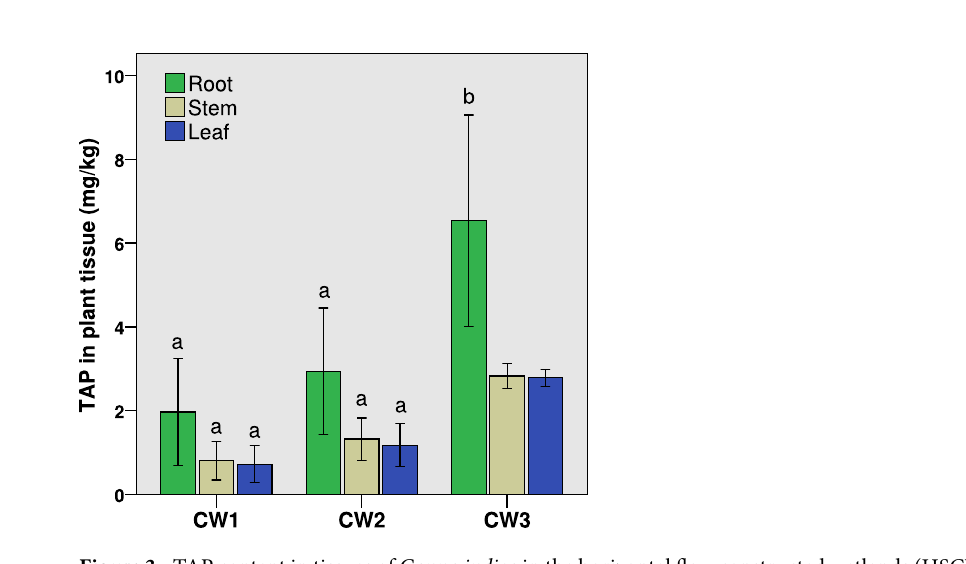
the TAP accumulation in plants and substrates to the total TAP removal were calculated based on the TAP mass